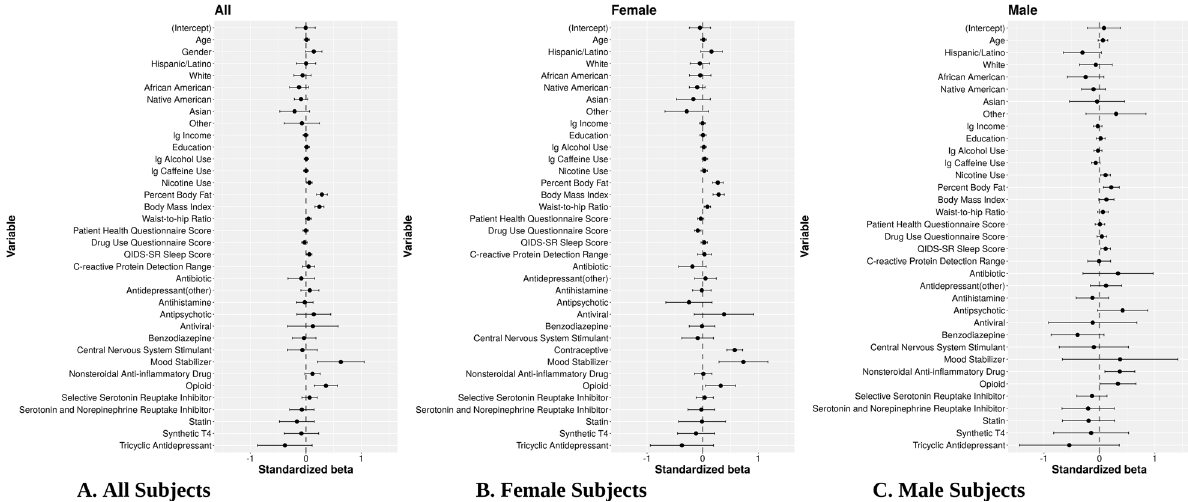
Fig. 2 Standardized beta coef fi cients and association between CRP and all covariates in multivariate linear regression. Standardized beta coef fi cients and corresponding 95% con fi dence intervals are depicted as dots and error bars. A Signi fi cant variables for the combined male and female sample (All) included mood stabilizer and opioid use, PBF, BMI, nicotine use, male sex, and QIDS-SR sleep score. B Additional signi fi cant variables for the female-only sample included oral contraceptive use (OC use), WHR, and DAST score. C Additional signi fi cant variables for male-only sample included NSAID